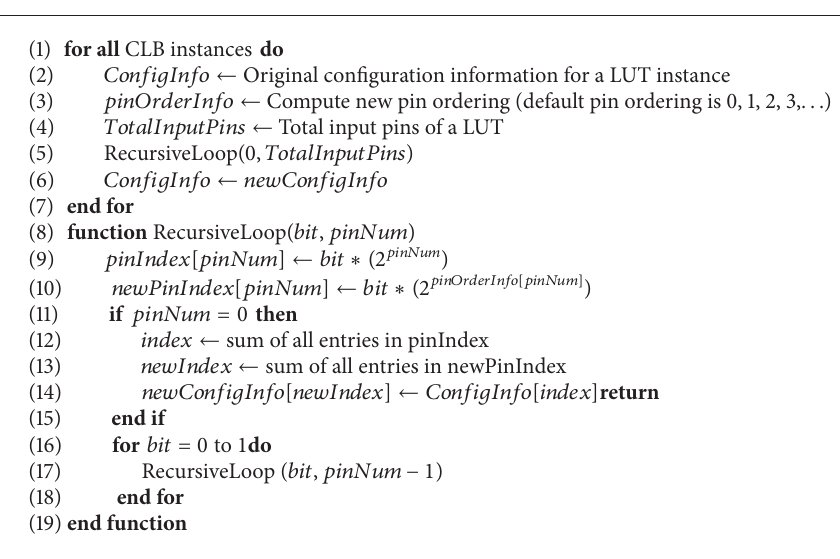
Algorithm 2: Algorithm to change LUT configuration for different pin connectivity